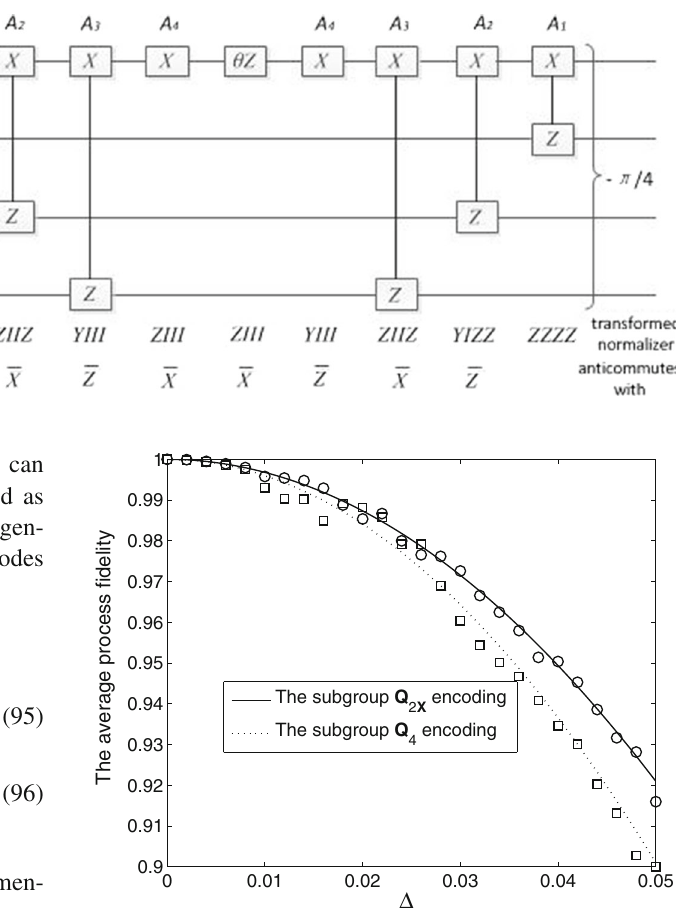
Fig. 4 The average process fidelity when performing the gate with random fluctuations in gate times, subgroups Q 4 and Q 2 X encoding of QEAC are, respectively, shown, where Q 4 has three-qubit encoding and Q 2 X has one-qubit